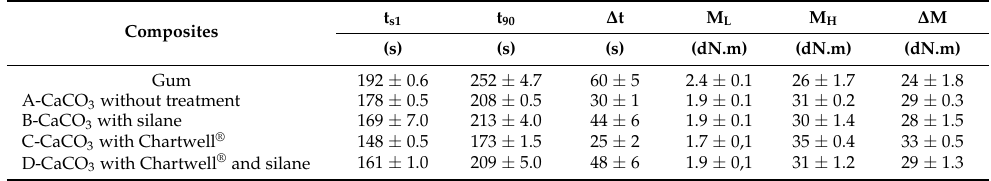
Table 3. Rheometric properties of the NR composites with 40 phr of calcium carbonate (CaCO 3 ) measured with 1° of disk oscillation and isotherms at 150 °C. Only the coupling agents were changed. Gum is included as a reference point.